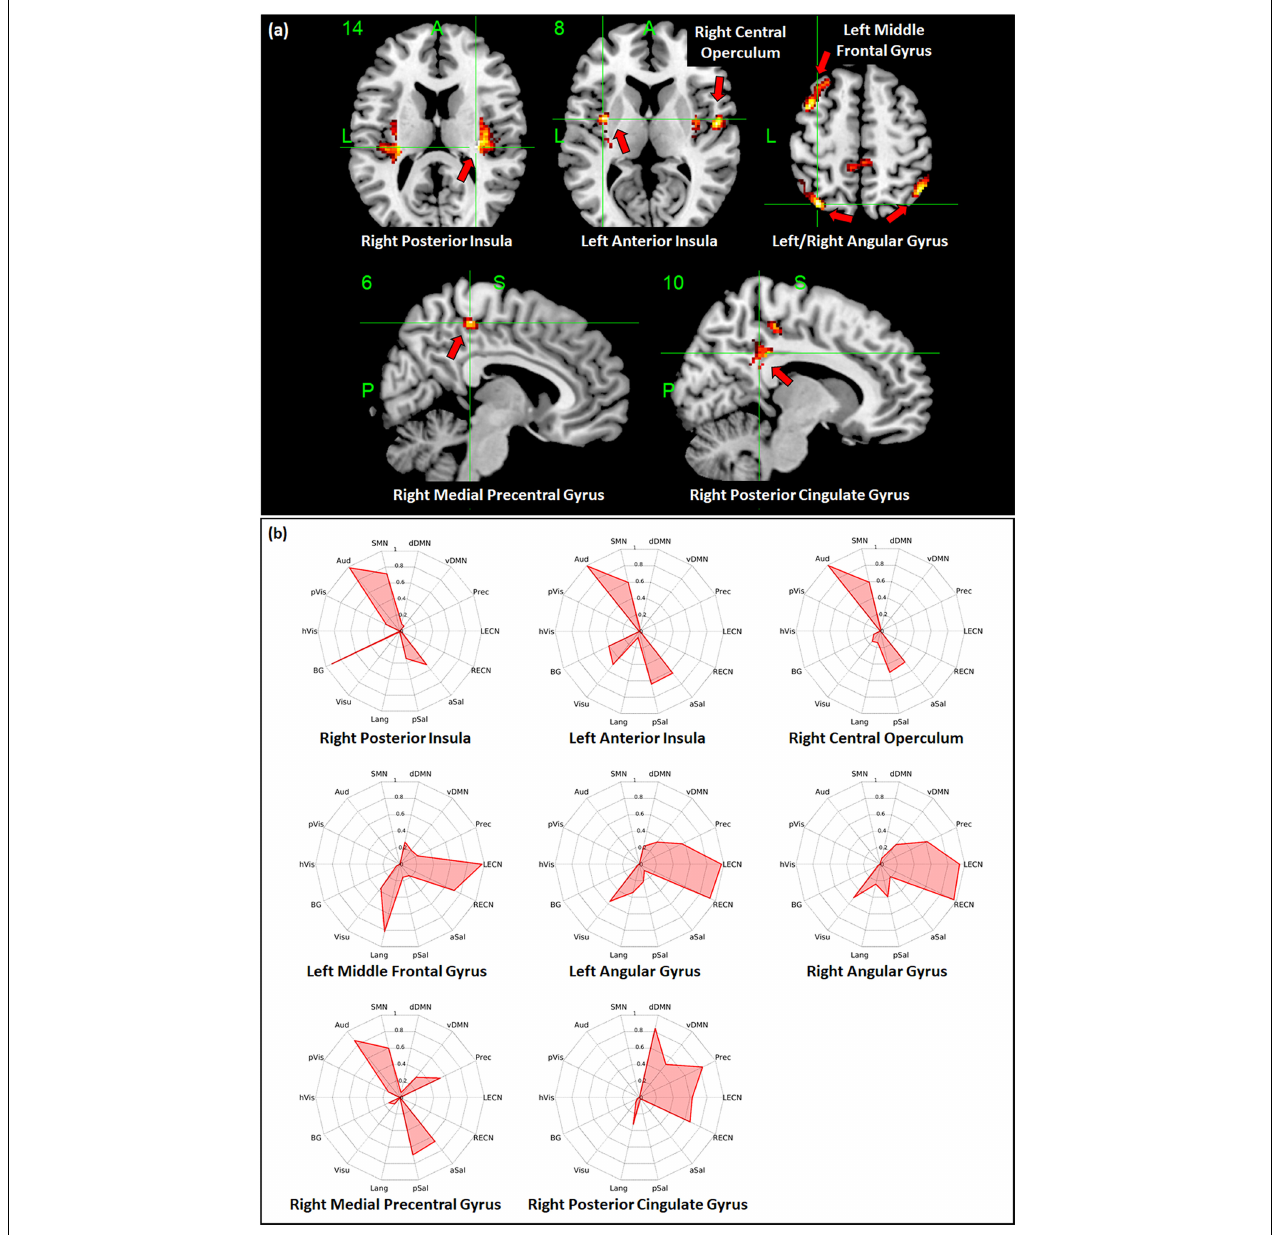
FIGURE 5 | Relationship between long-range intrinsic connectivity contrast (ICC) values and age. (a) Regions with long-range ICC values that showed significant (FWEc p < 0.05, CDT p = 0.001) negative linear relationship with age. (b) Spider plots of the overlap ratio quantifying the connection between the 14 canonical resting state networks and the regions shown in (a) . dDMN, dorsal default mode network; vDMN, ventral default mode network; Prec, precuneus network; LECN, left executive control network; RECN, right executive control network; aSal, anterior salience network; pSal, posterior salience network; Lang, language network; Visu, visuospatial (dorsal attention) network; BG, basal ganglia network; hVis, high visual network; pVis, primary visual network; Aud, auditory network; SMN, sensorimotor network; R, right; L,